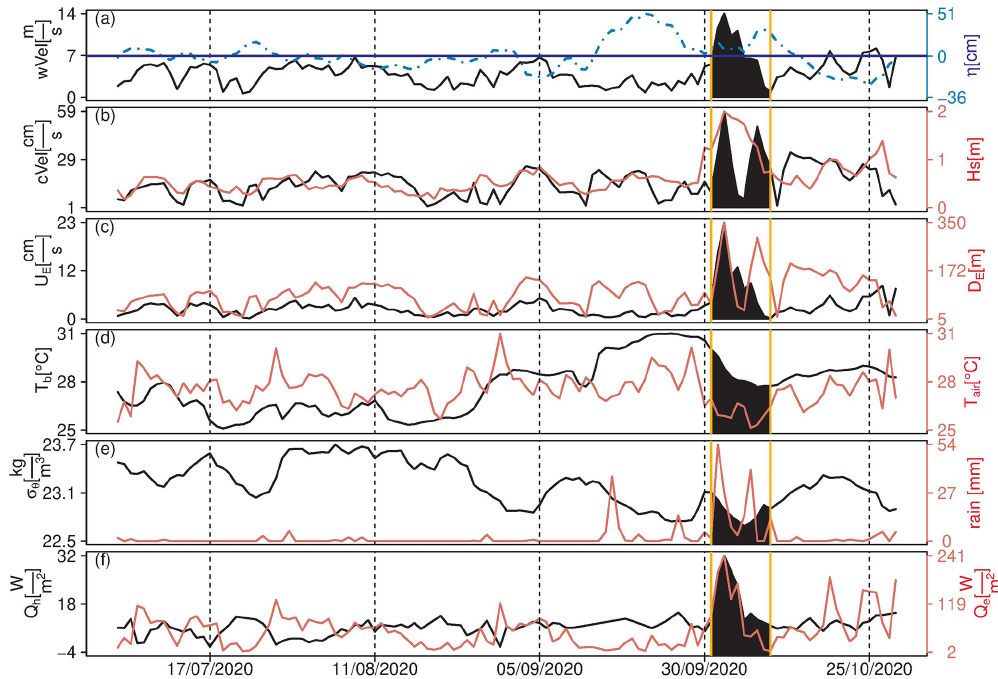
Figure 3. Time series of (a) wind velocity and sea surface height (in blue), (b) current velocity and significant wave height (in red), (c) Ekman currents and Ekman layer depth (in red), (d) sea bottom temperature and air temperature (in red), (e) seawater density and precipitation (in red), and (f) sensible and latent heat (in red), estimated from the meteorological station, the moored ADCP, and the satellite data. The dates of the passage of storms Gamma and Delta are highlighted. The date format is dd/mm/yyyy.